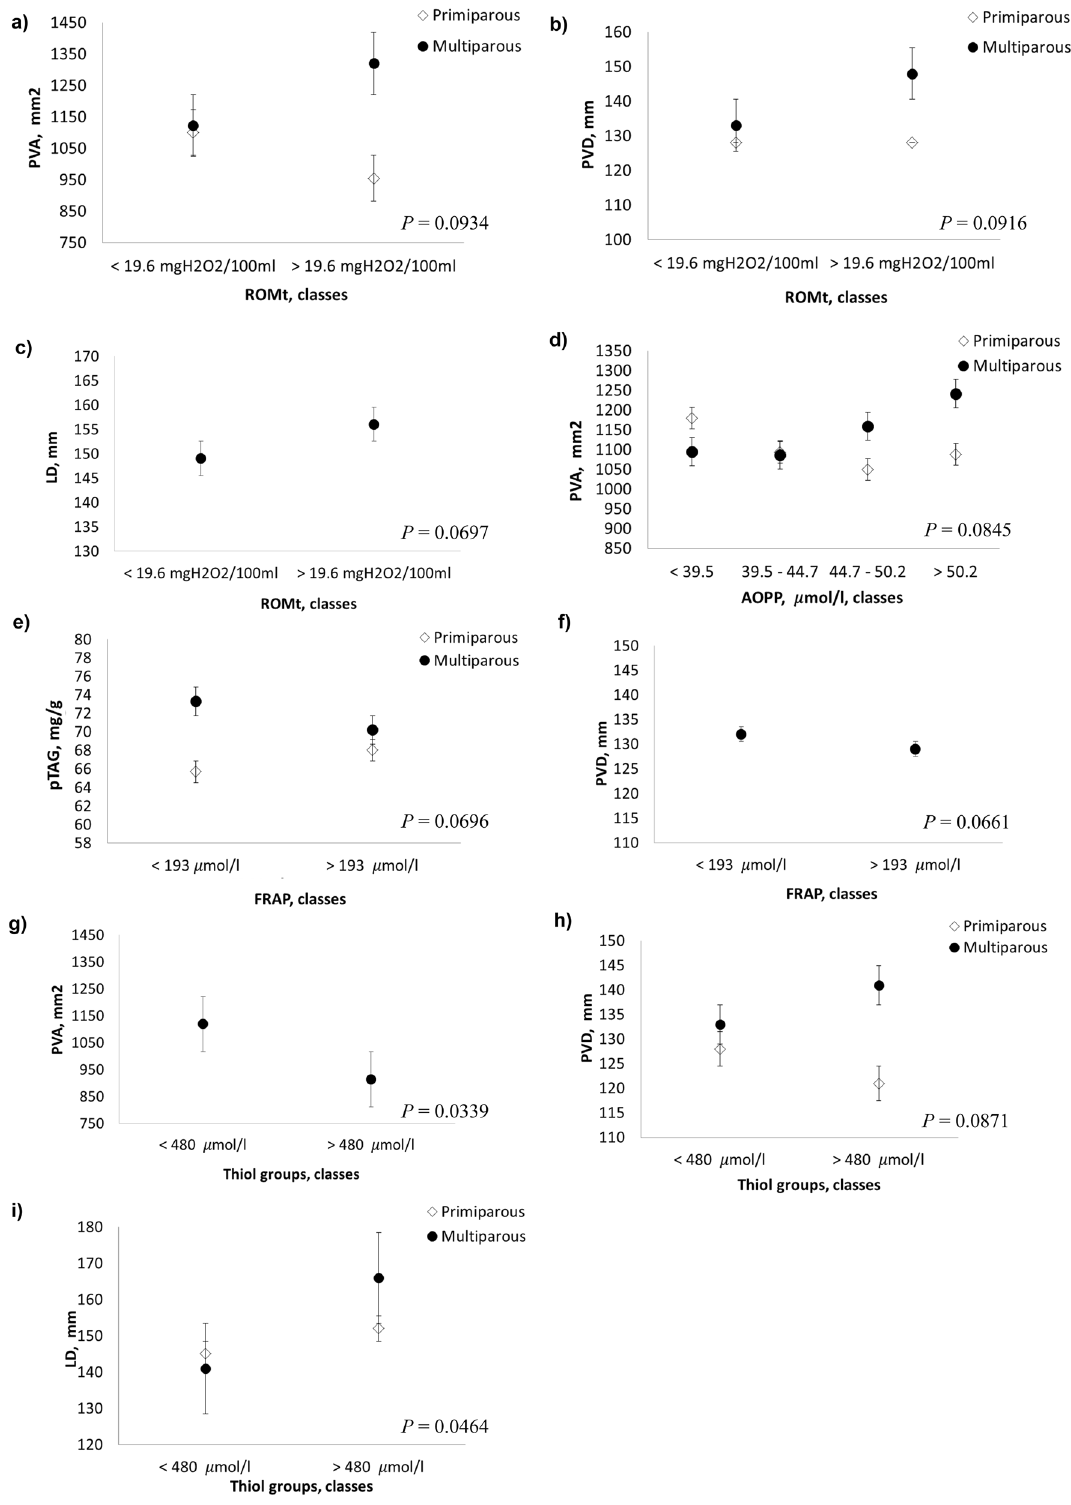
Figure 4. Least squares means (LSM) for predicted liver triacylglycerol (pTAG), portal vein area (PVA) portal vein depth (PVD) and liver depth (LD) across the classes of liver oxidative stress hematic parameters. ( a – c ) Total reactive oxygen metabolites (ROMt); ( d ) advanced oxidation protein products (AOPP); ( e , f ) Ferric reducing ability of plasma (FRAP); ( g – i ) thiol groups. Black dots/rhombus indicate the LSM and error bars indicate the standard